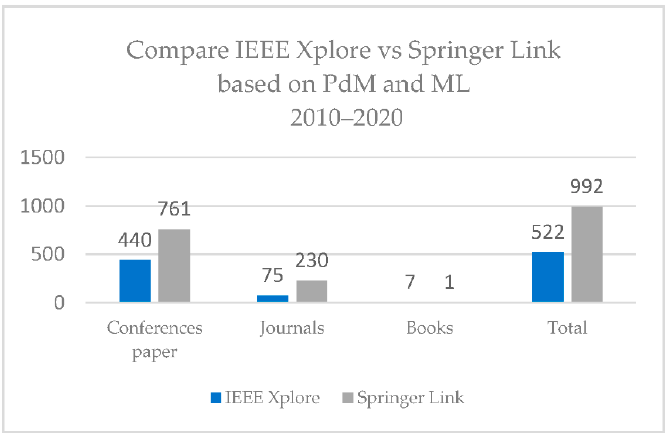
Figure 4. Compare IEEE Xplore vs. Springer Link Studies based on PdM and ML methods.